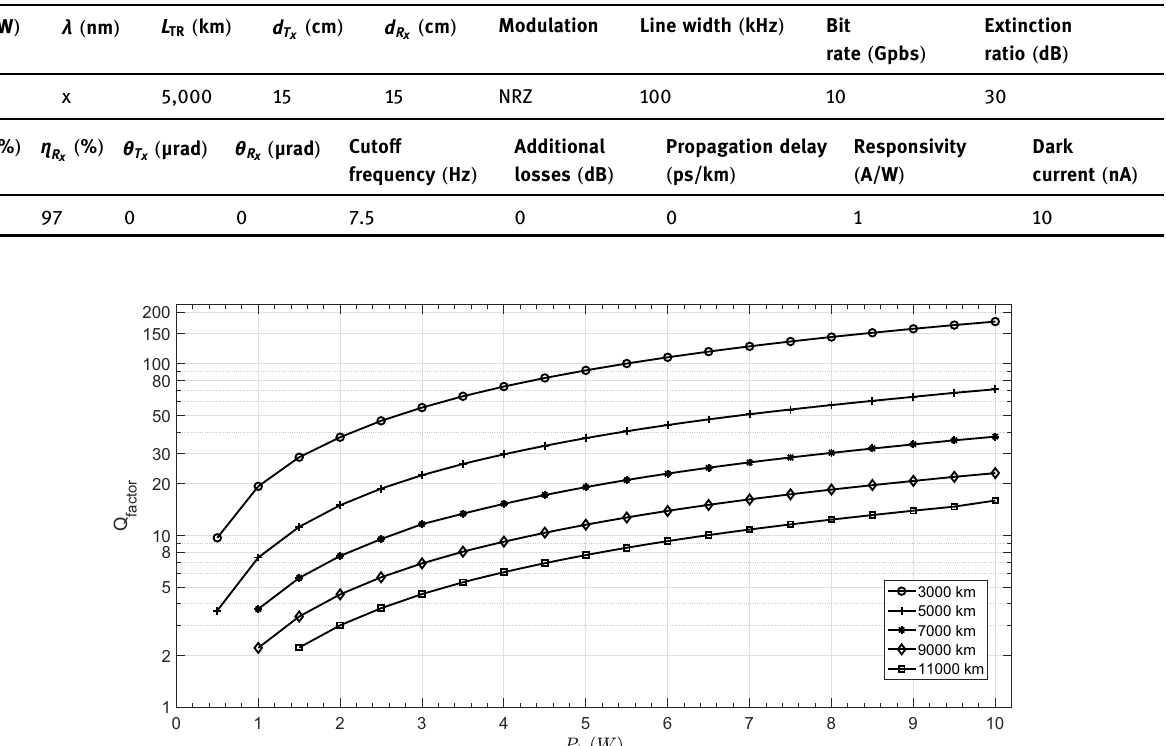
Figure 4: Quality factor ( Q factor ) as a function of the transmitted laser power ( P W in ( ) ) for di ff erent distances ( km ) between satellites W/zero pointing error.